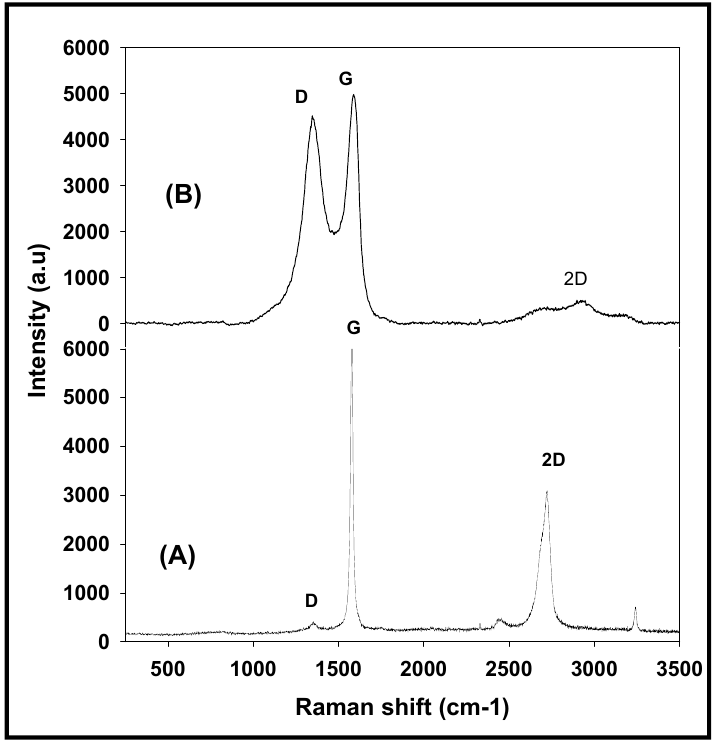
Figure 2. Raman spectra of pristine Gr ( A ) and GrO ( B ).